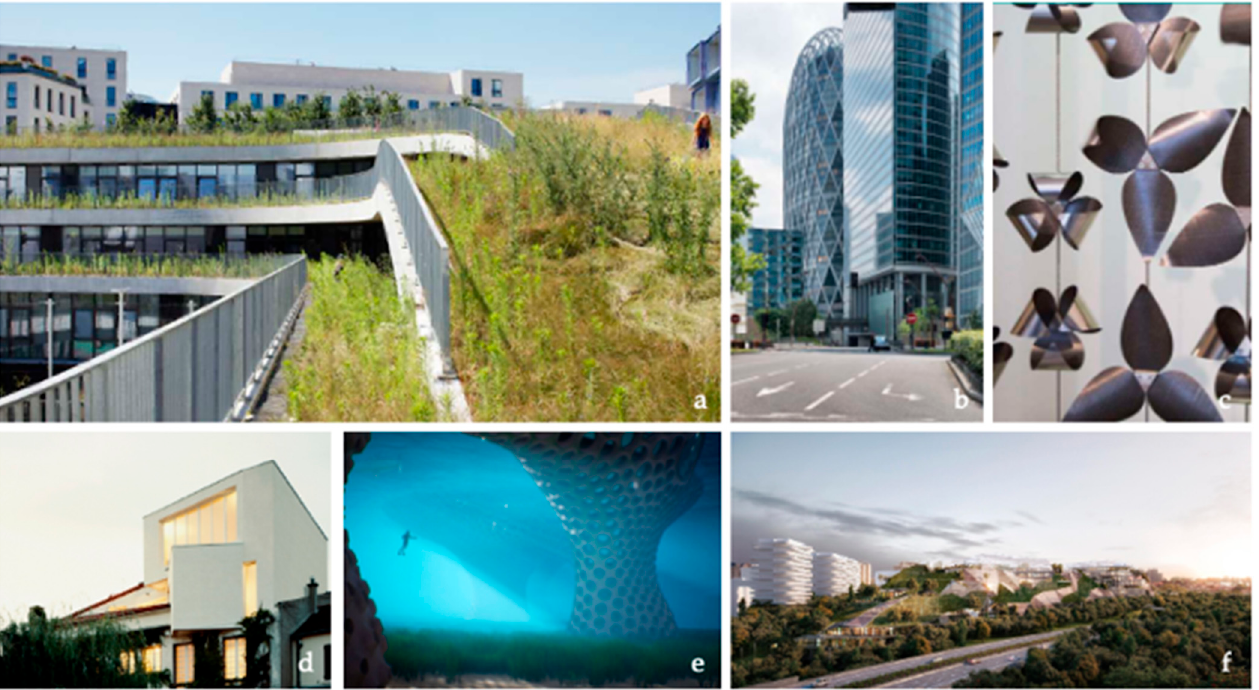
Figure 2. Built bioinspired buildings located in France ( a ) Ecole des sciences et de la biodiversité, Boulogne-Billancourt, 2015 © ChartierDalix – Takuji Shimmura, ( b ) D2 tower © Pierre Elie de Pibrac, ( c ) © ArtBuild, ( d ) © In Situ Architecture, ( e ) © Rougerie+Tangram, ( f ) © Tryptique Architecture.